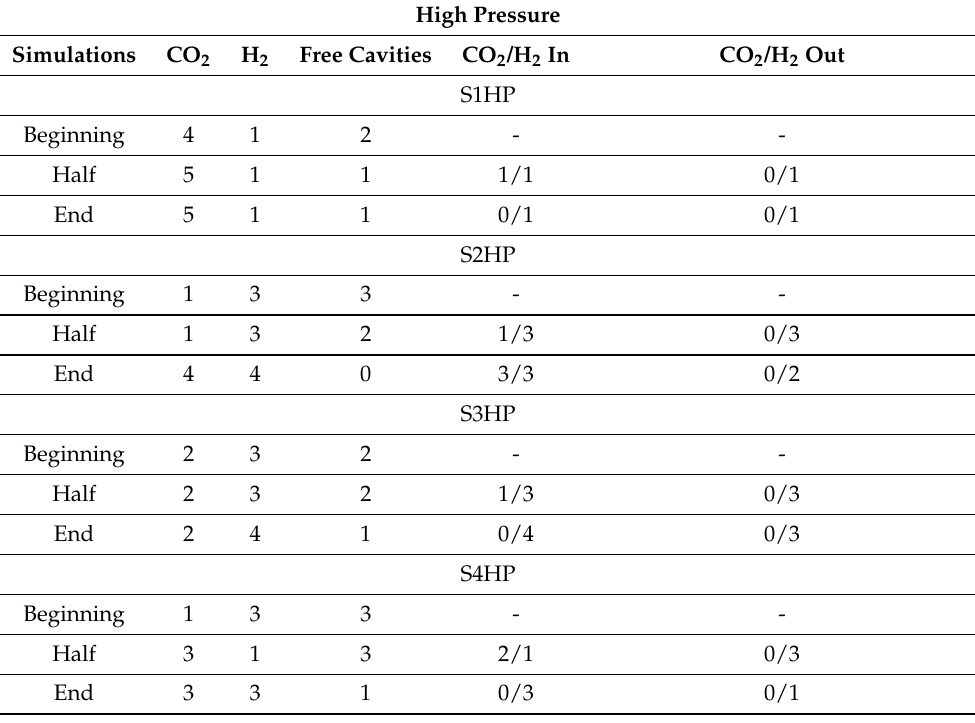
Table 4. Simulations for the HP runs (300 K and 100